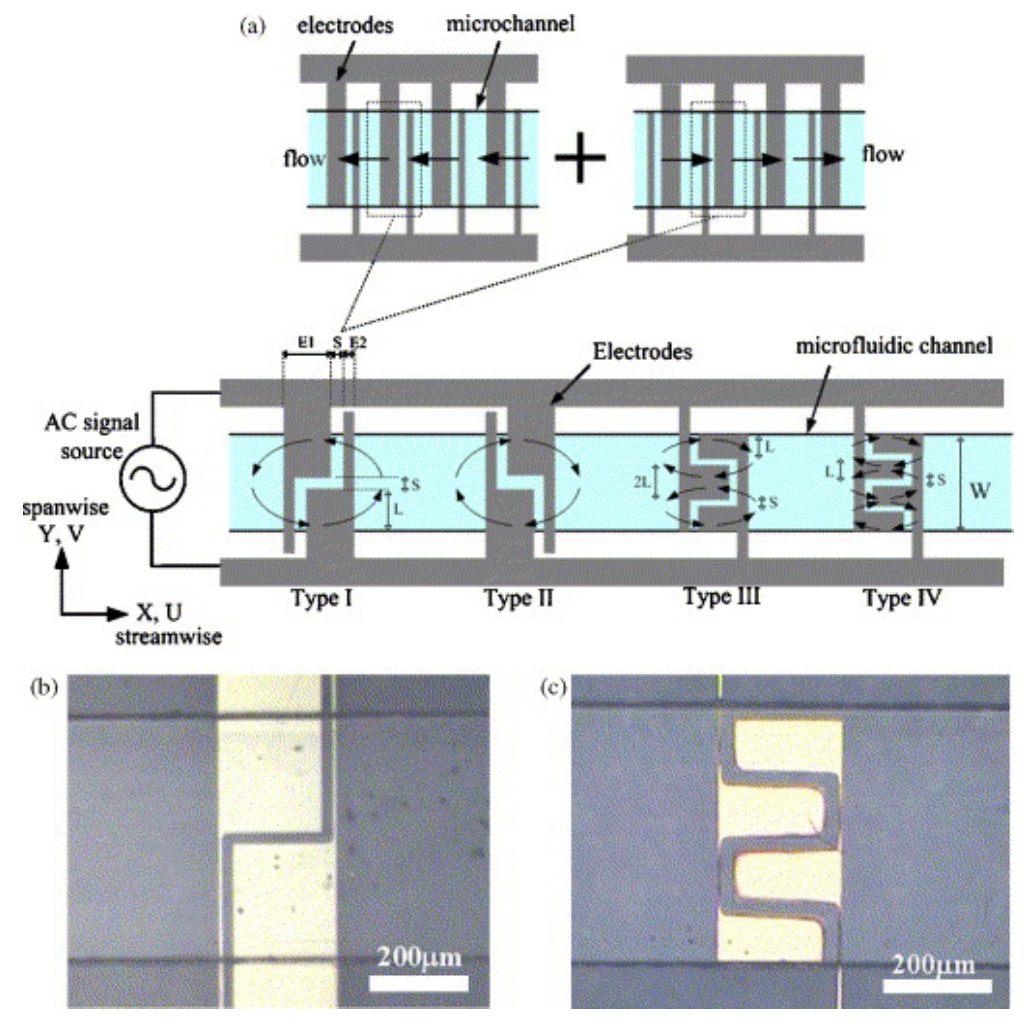
Figure 24. (a) Various designs of electrode patterning for creating local vortices with ac electroosmosis. (b) and (c) show pictures of design types I and IV, respectively (from Huang et al. [46]).